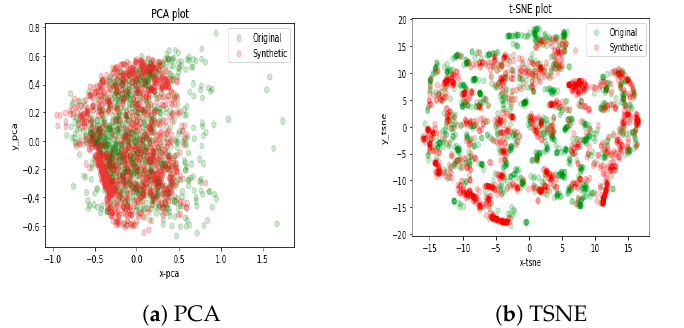
Figure 10. Scenario 4—RMSProp (lr = 0.001, decay =